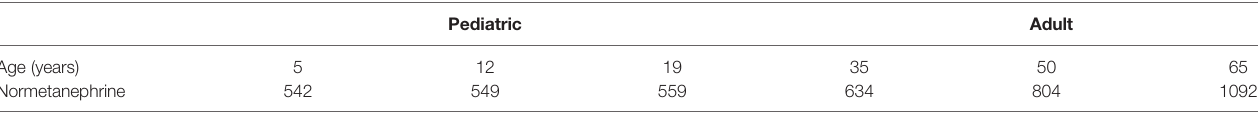
Units expressed as pmol/L. Values between 5 and 65 years of age were interpolated based on the equation in reference